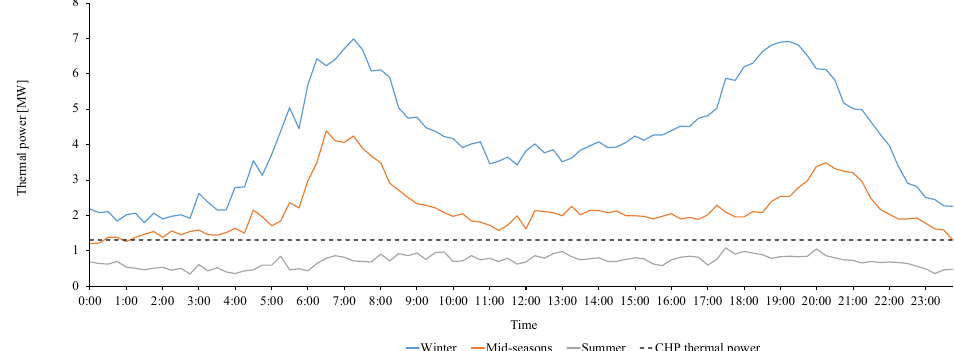
Figure 10. The trend of typical daily heat demand in winter, mid-, and summer seasons.